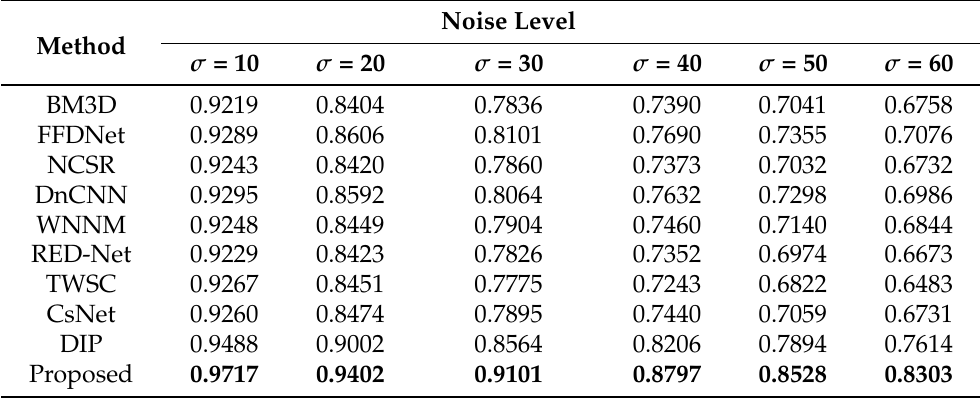
Table 10. Average SSIM results of different methods on BSD50 with various noise levels.